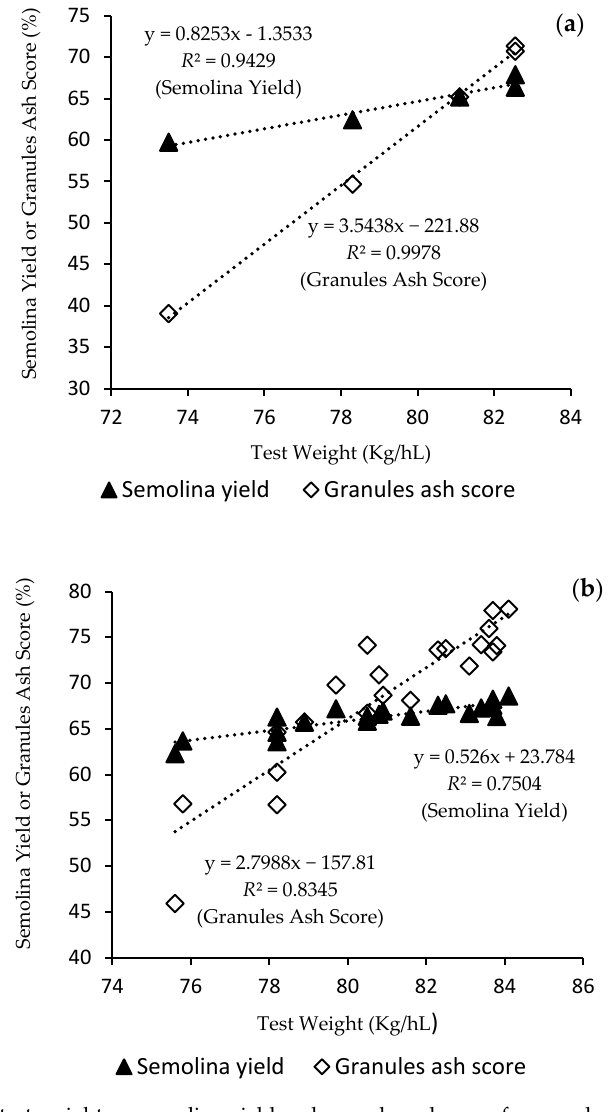
Figure 1. Impact of test weight on semolina yield and granules ash score for sample set I ( a ) and set II ( b ).